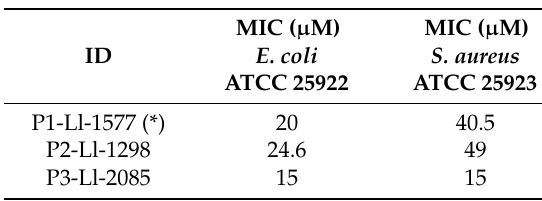
Table 3. MIC of the analogs.